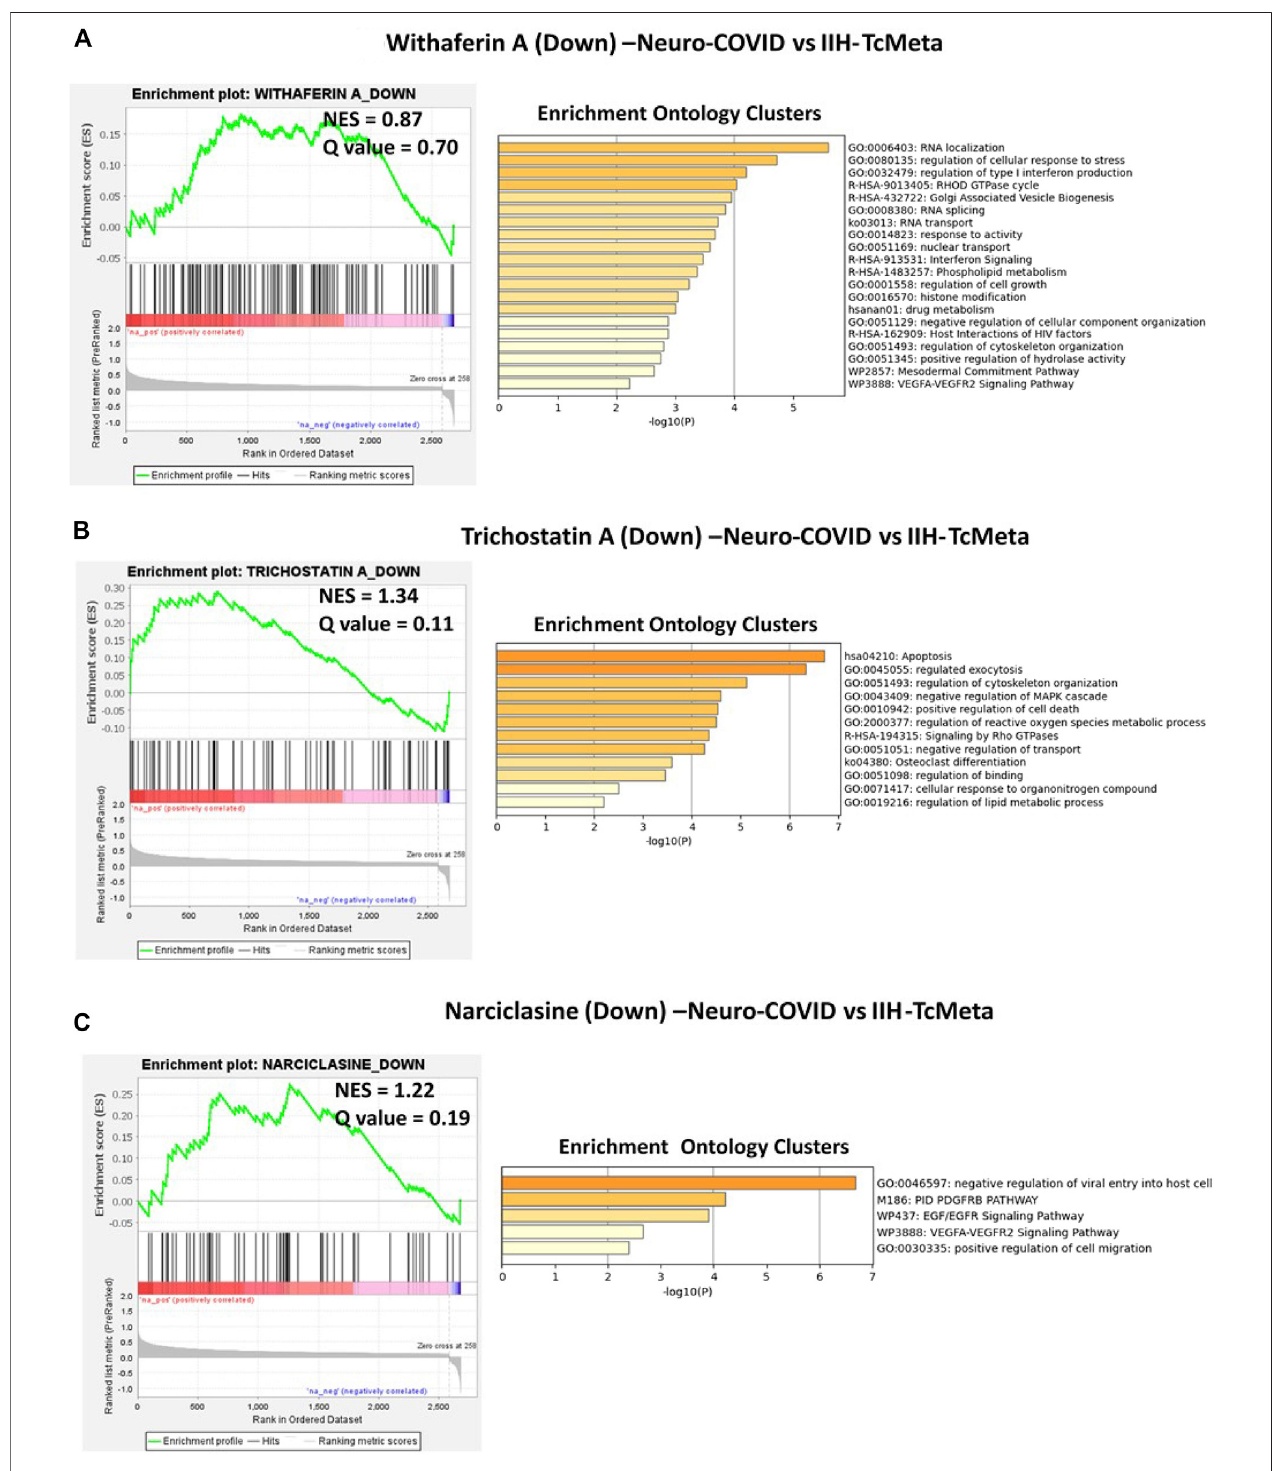
FIGURE 6 | GSEA preranked analysis was performed to decipher the potential gene signatures downregulated by withaferin A, trichostatin A, and narciclasine using the RNK fi le generated from DEGs of Neuro-COVID vs. IIH (TcMeta) comparison. The Metascape analyses to decipher the GO clusters based on the (A) enrichmentofgenesignature(SignatureID:CPC014_VCAP_6H:BRD-A52193669:10.0)downregulatedbywithaferinA, (B) enrichmentofgenesignature(SignatureID: CPC012_A375_6H: BRD-K68202742:10.0) downregulated by trichostatin A, and (C) enrichment of gene signature (Signature ID: CPC006_HA1E_24H: BRD- K06792661:10.0) downregulated by narciclasine in Neuro-COVID vs. IIH-TcMeta.